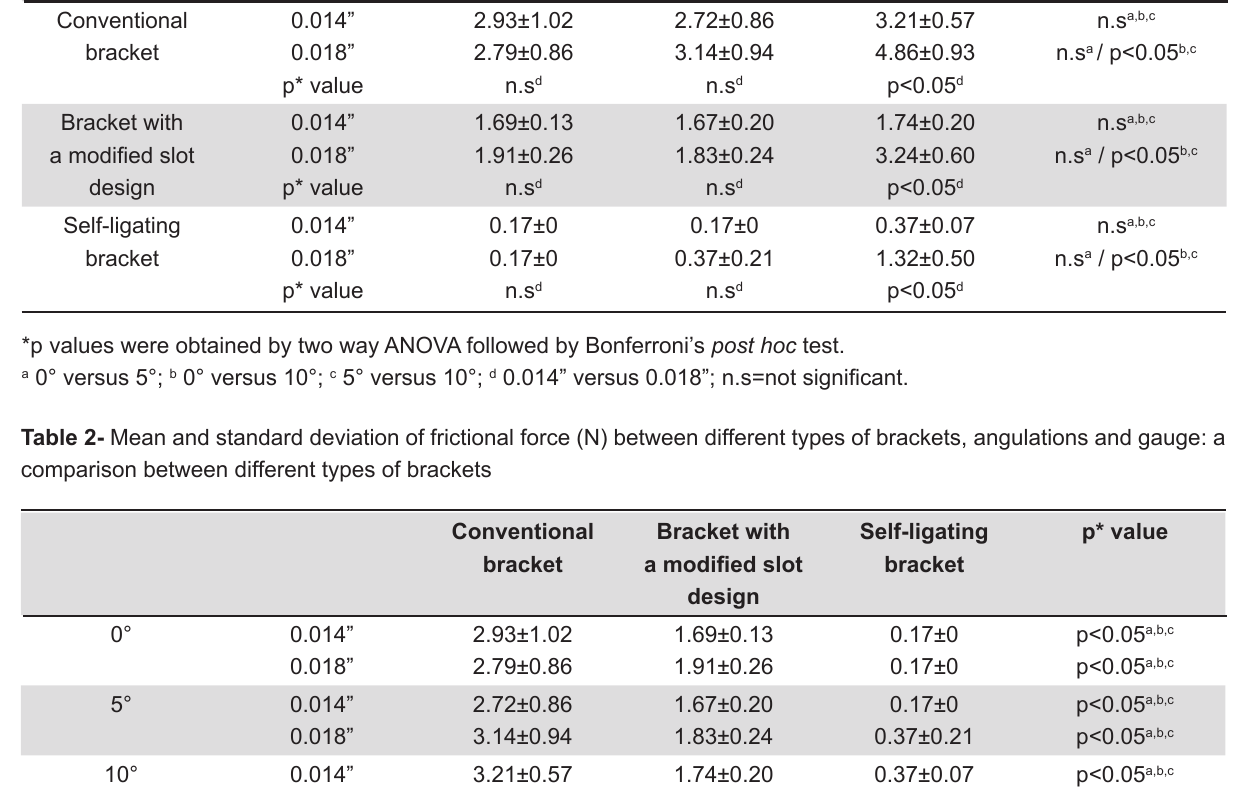
Table 1- Mean and standard deviation of frictional force (N) between different types of brackets, angulations and gauge: a comparison between angulation and wire gauge